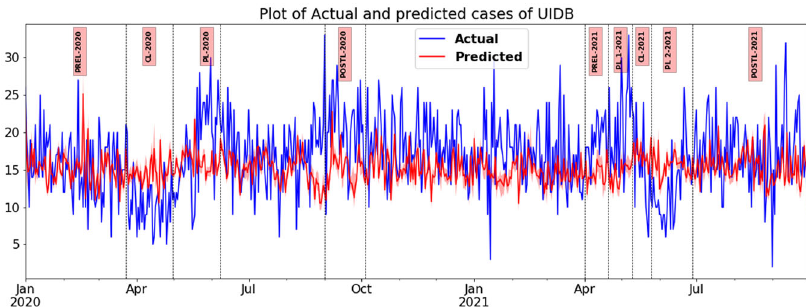
Fig. 8 Plot of actual and predicted number of unidenti fi ed dead body (UIDB) cases using an auto-regressive neural network. x -axis — timeline of various lockdown phases in both waves in Tamil Nadu. y -axis — daily count of unidenti fi ed dead body (UIDB) cases registered (actual and predicted). The vertical bars space out the different lockdown phases such as CL — complete lockdown, PL — partial lockdown and Post-L — post lockdown.